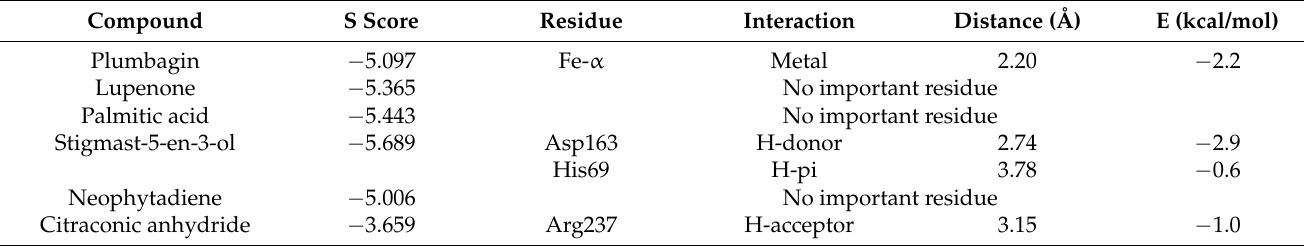
Table 4. Results of the docking studies against